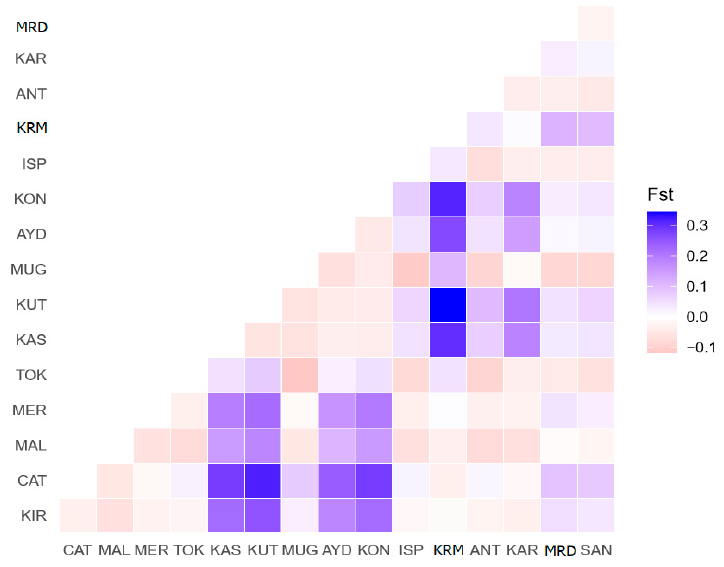
Figure 3. Pairwise F ST values for the 16 Turkish indigenous donkey population comparisons.